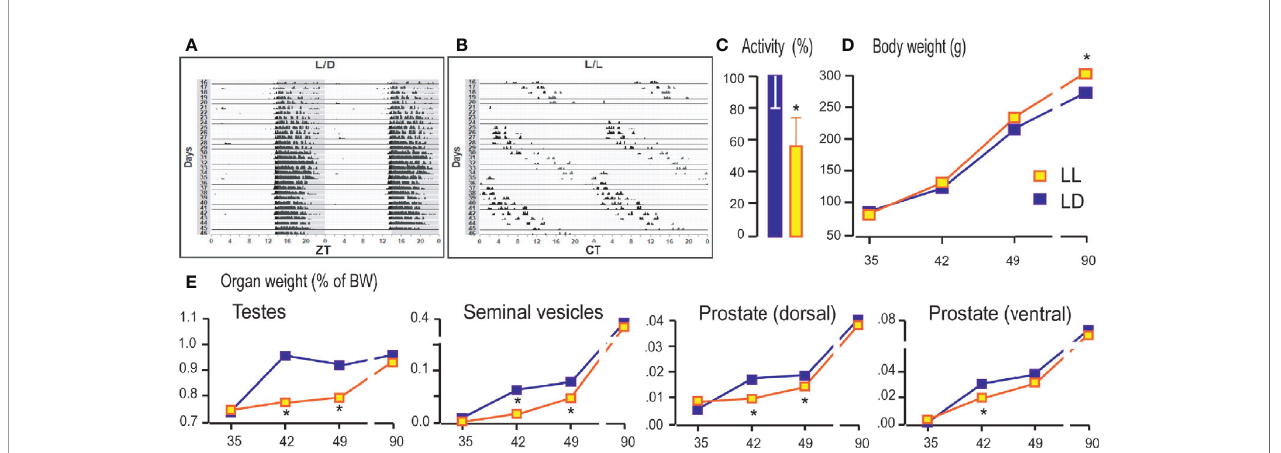
FIGURE 1 | Growing up under constant light changed activity patterns, body and reproductive organs weight. Rats were raised under the controlled light regime of 14 h light – 10 h dark (LD) or were exposed to constant light conditions (LL) until P35, P42, P49, and P90. From P60 to P90 the rats ’ voluntary activity was monitored and actograms formed. The representative actograms from LD (A) and LL (B) condition as well as average daily activity (C) are shown. Rats were monitored for body mass (D) and weight of testes and accessory organs (E) . Data points/bars represent group means ± SEM values (n = 5 – 8). *Statistical signi fi cance at level p < 0.05 compared to the corresponding LD